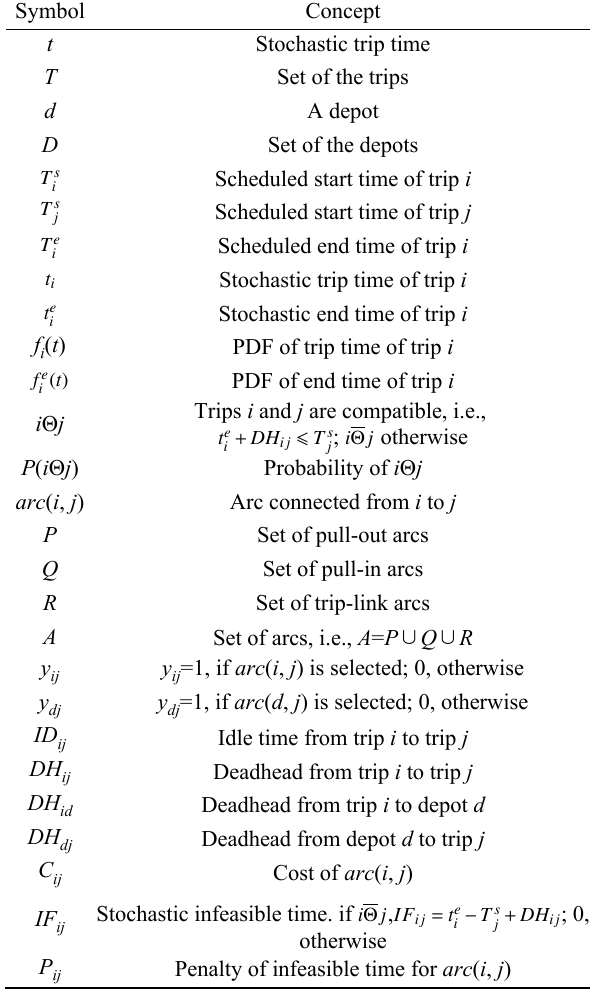
Table 1 Symbols and concepts for the model of SVSP.